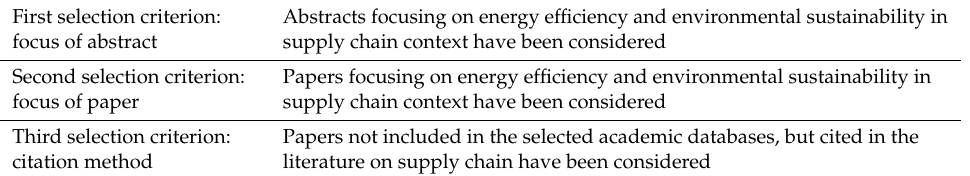
Table 2. Three selection criteria.